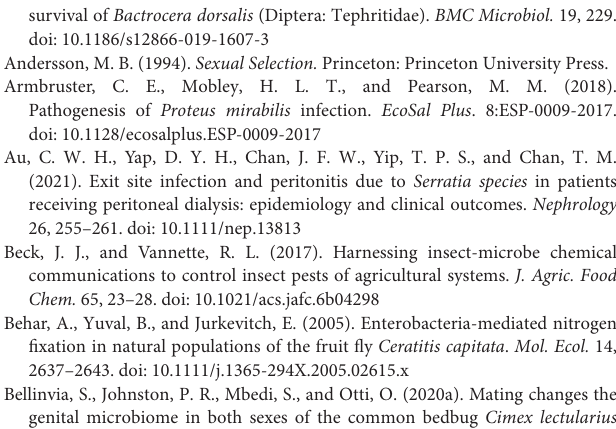
Supplementary Figure 1 | Rarefaction curves represent observed OTUs in different samples. Supplementary Figure 2 | The Venn (A) and petals (B) diagrams of OTUs from different mating types. Supplementary Figure 3 | The heat map of bacterial functions (top 35) in the FAPROTAX database for S. frugiperda females. The samples are grouped according to the similarity of each other. Different colors indicate the relative abundance of groups in the individual samples, wherein red represents the function with higher abundance, and blue represents the function with lower abundance in the corresponding sample. Supplementary Figure 4 | Cladogram of the LDA results, where rings from the inner to outer indicate phylum, class, order, family, and genus,